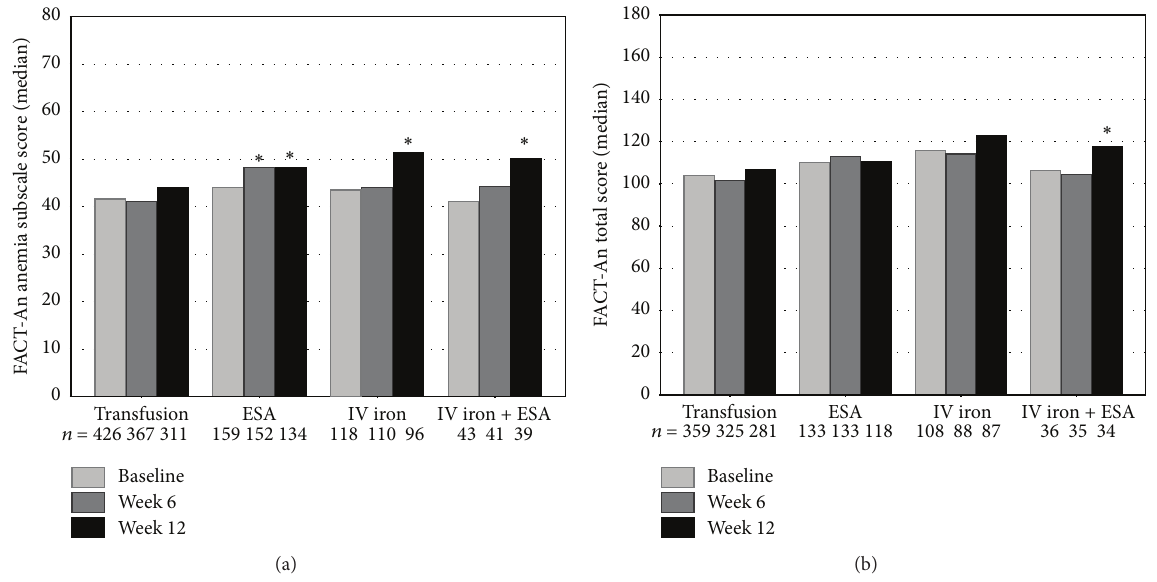
Figure 4: Quality of life (QoL) of patients assessed by the FACT-An questionnaire at baseline and after 6 and 12 weeks of the observation period. (a) Anemia-specific subscale score range [0–80]; ∗ a difference of 4 points is considered clinically relevant [14, 15]; (b) FACT-An total score range [0–188]; ∗ a difference of 7 points is considered clinically relevant [14, 15]; higher scores indicate a better QoL; numbers indicate the number of questionnaires